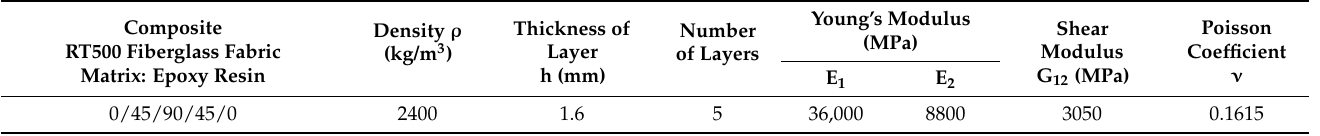
Table 1. Elastic properties of each composite layer.